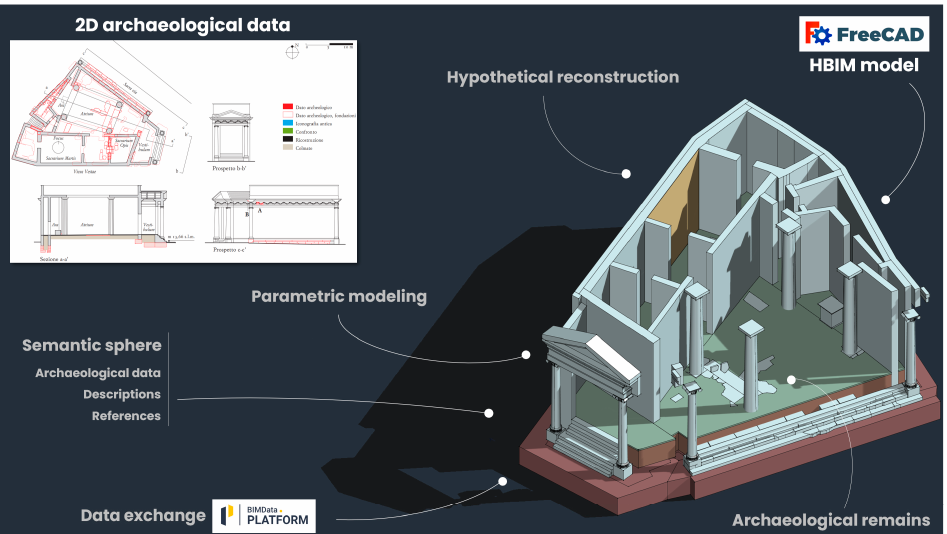
Figure 6. The Domus Regia project: from 2D archaeological data to HBIM model and data exchange exclusively with open source